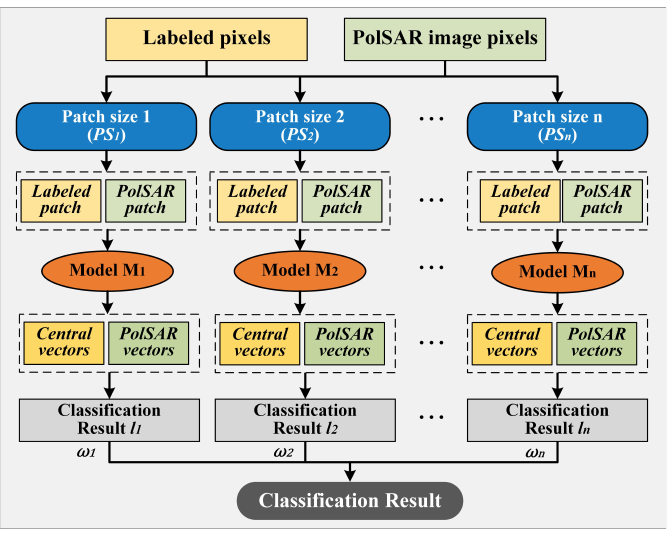
Figure 9. Classification